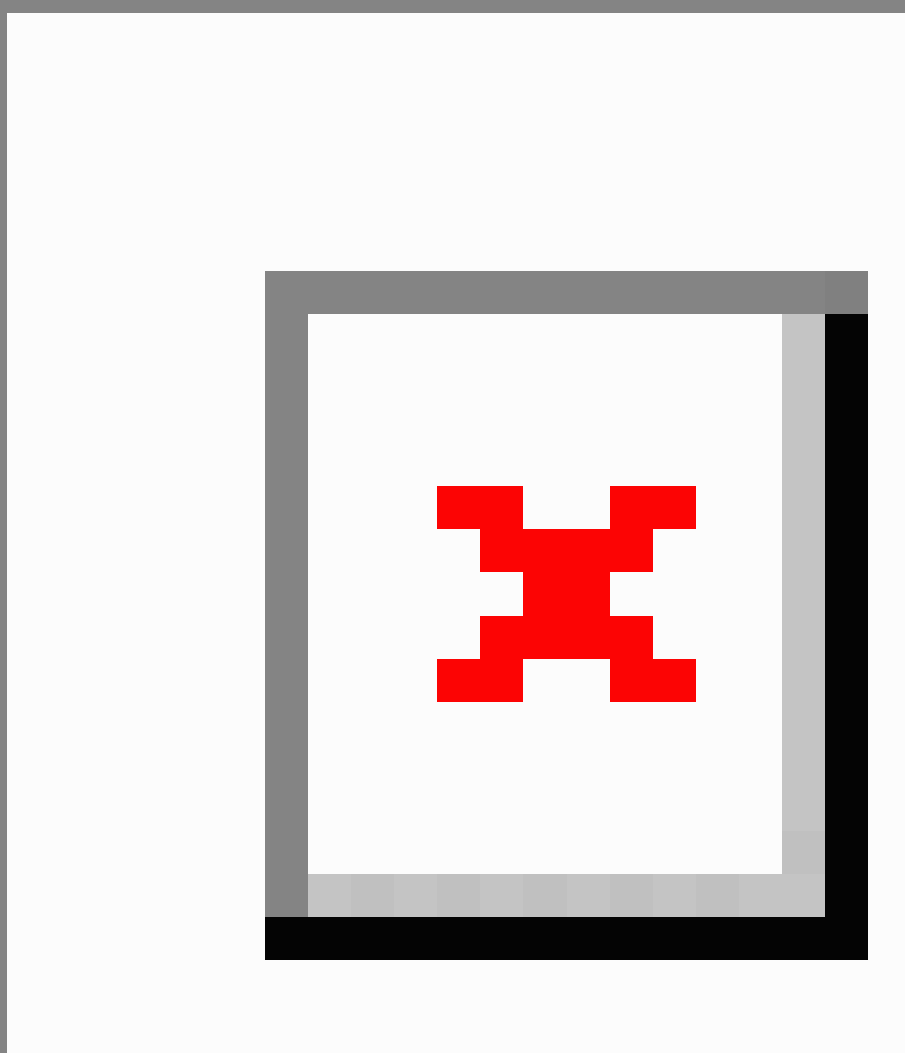
Figure 2. Screenshots of the mobile weight loss